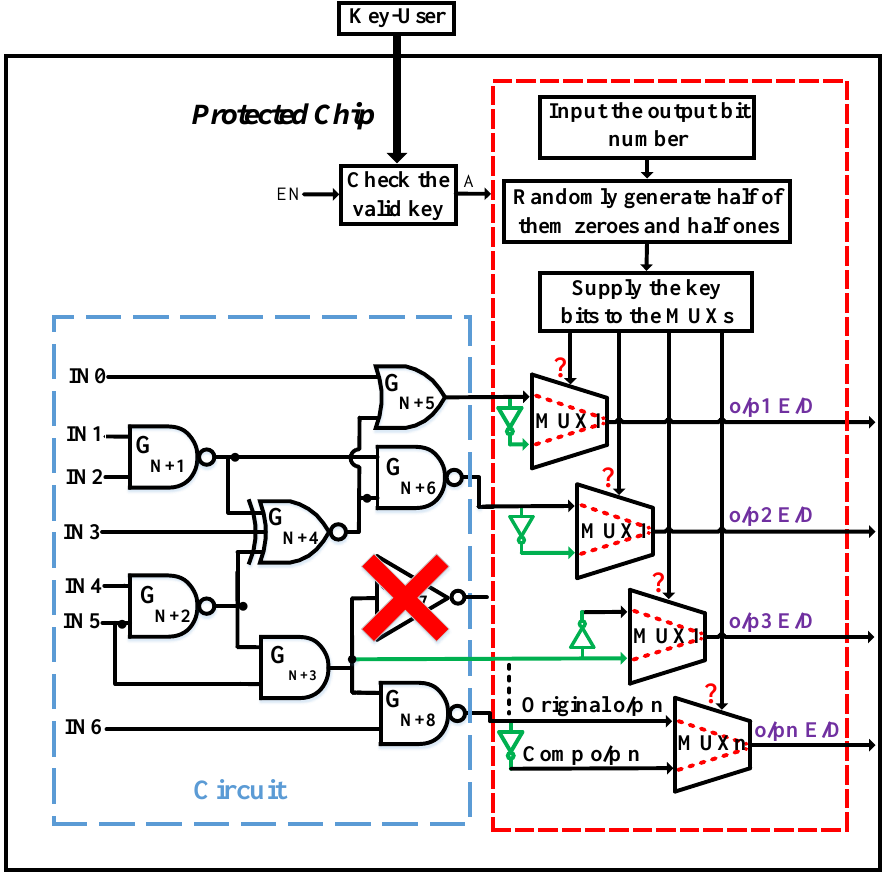
Figure 5. Logic encryption based on full MUX